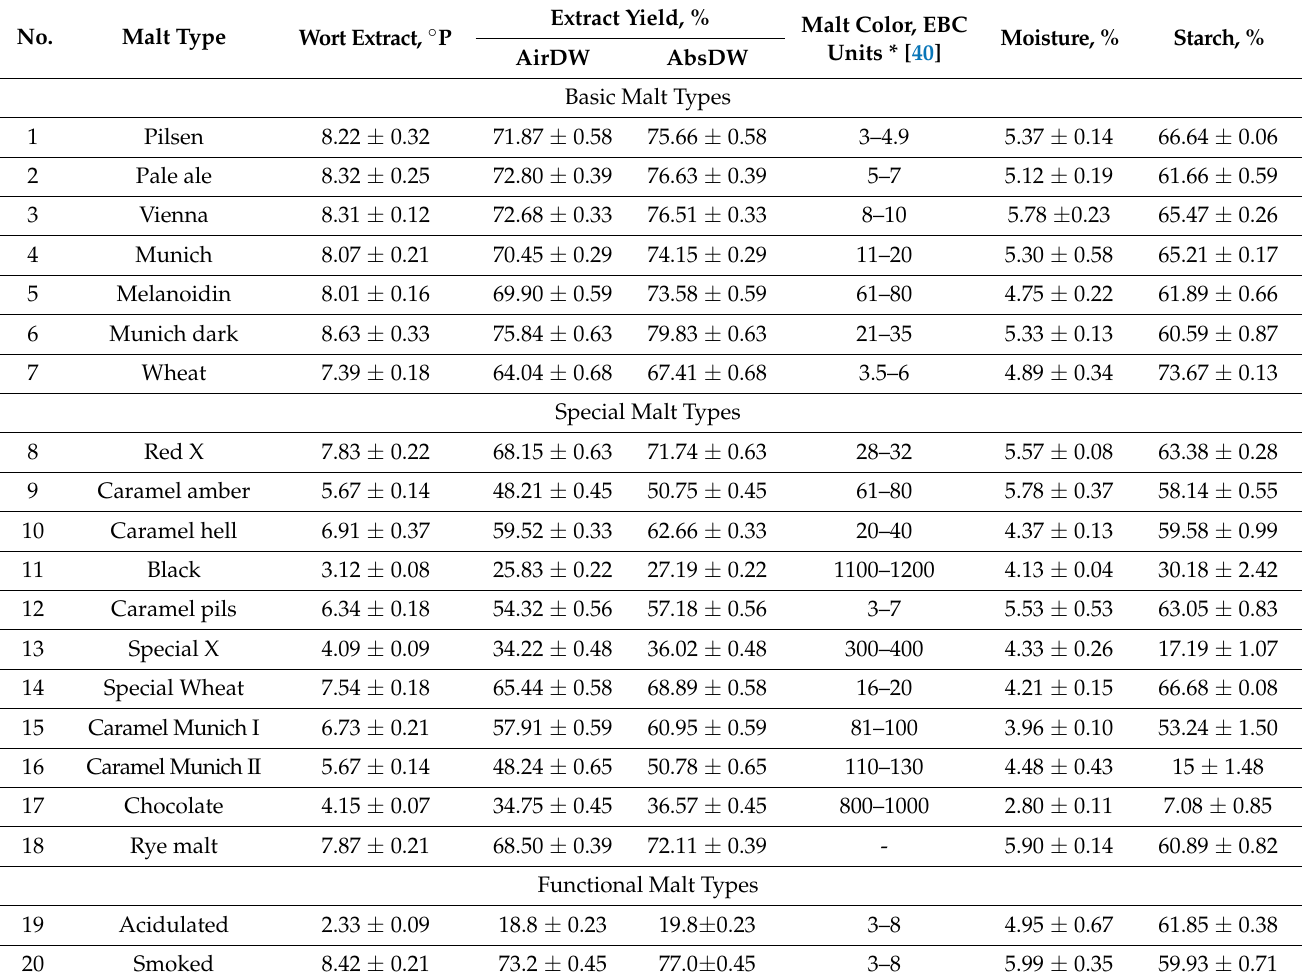
Table 1. Main brewing characteristics of the studied